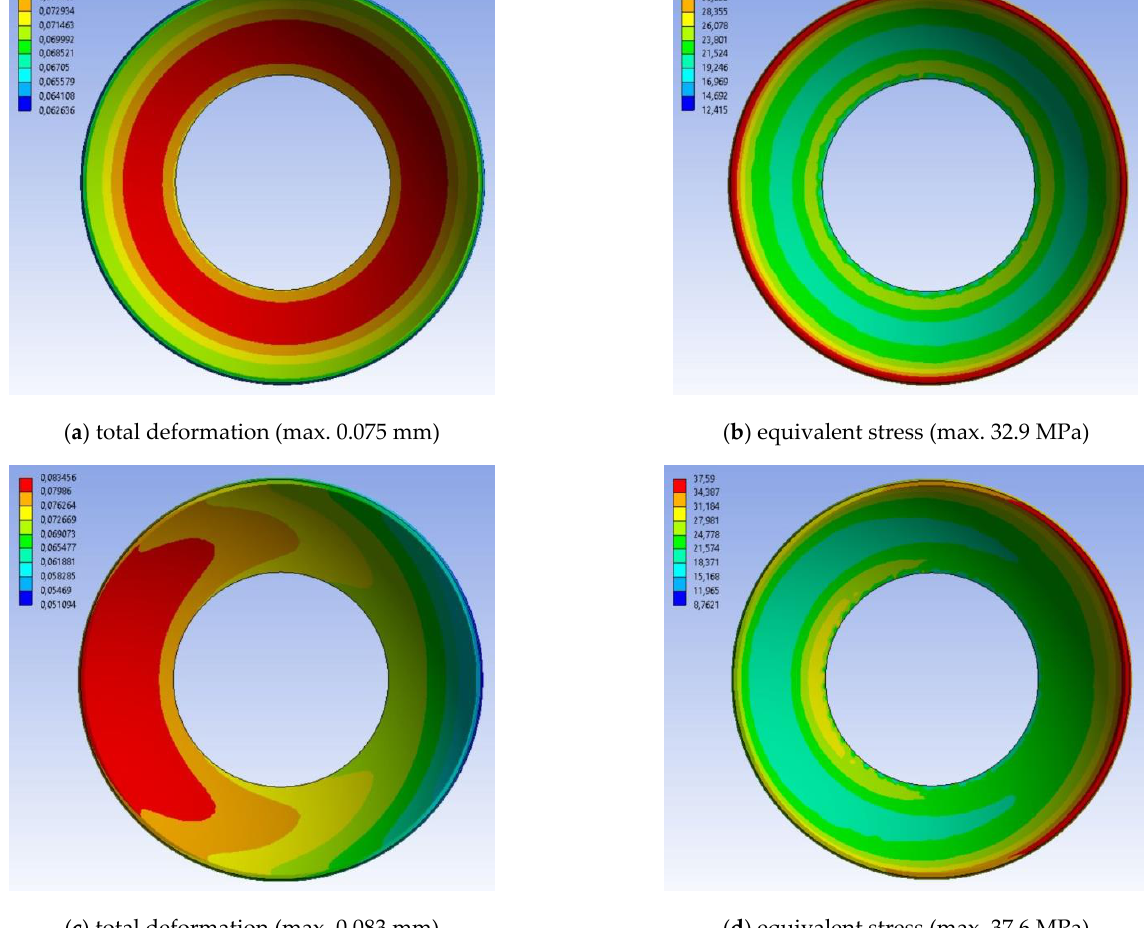
Figure 8. Bronze liner embedded with no clearance, vertical load from the fixed weight of the loaded body, coefficient of friction μ = 0.1, vertical and lateral load components: ( a , b ) Fz = 350 kN, Fy = 0 N ( c , d ) Fz = 350 kN, Fy = 42 kN, ( a ) maximum contact pressure 17.5 MPa, ( b ) maximum equivalent stress 42.1 MPa.